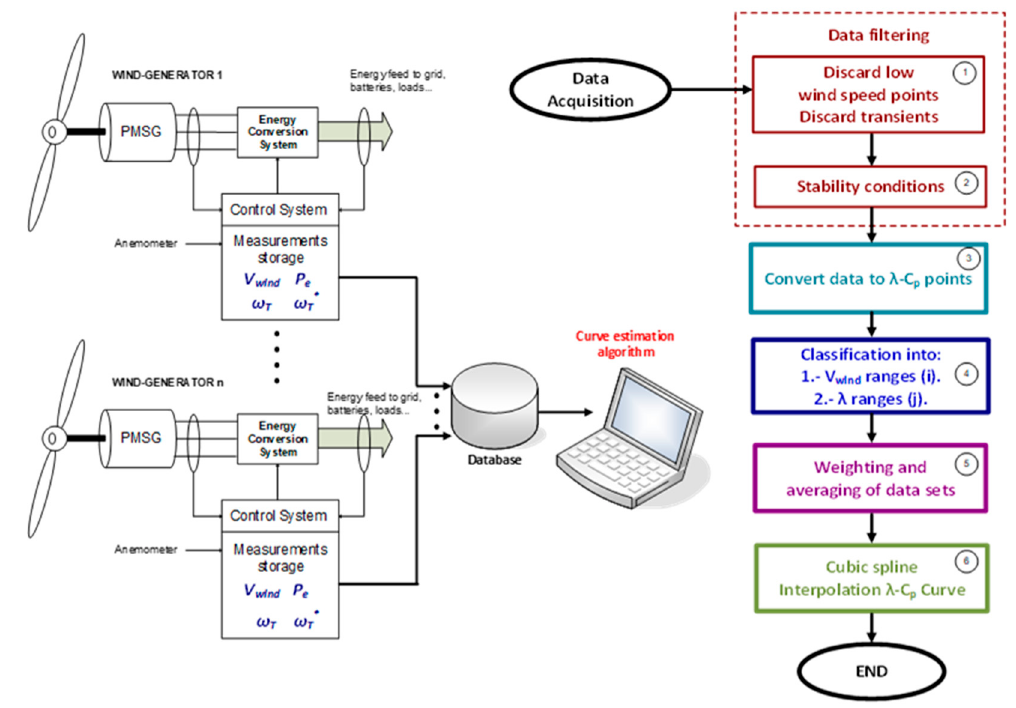
Figure 3. Block diagram of the data acquisition ( left ) and flowchart of the proposed method ( right ).